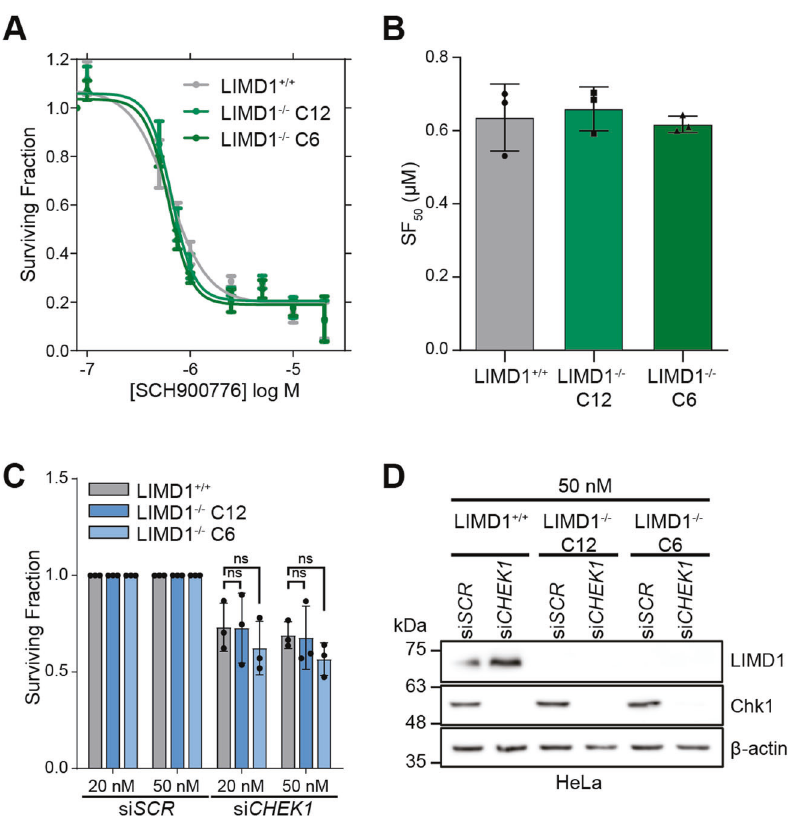
Fig. 2 PF-477736 selectively kills LIMD1 − / − cells independent of Chk1 inhibition. A Dose – response curve of SCH900776 in HeLa isogenic LIMD1 − / − lines. Cells were treated for 4 days before measuring viability and calculating surviving fraction ( n = 3). B Bar chart of SF 50 values from panel ( A ) ( n = 3, one-way ANOVA). C Surviving fraction of HeLa isogenic LIMD1 − / − lines transfected with siRNA against CHEK1 at 50 nM and 20 nM for 72 h ( n = 3, two-way ANOVA). ns p > 0.05. D Immunoblot of Chk1 and LIMD1 in HeLa isogenic LIMD1 − / − lines transfected with siRNA against CHEK1 (20 nM, 72 h) ( n =